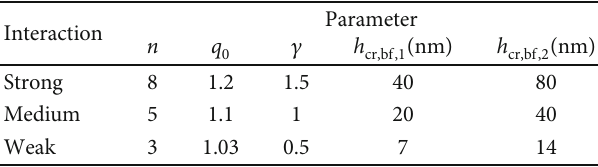
Table 4: The values of n , q bearing surface